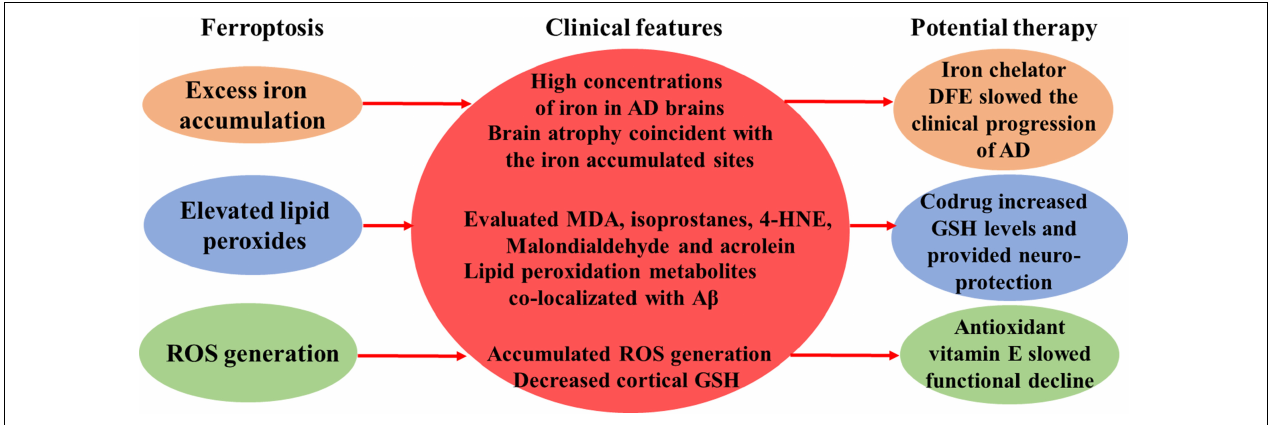
FIGURE 1 | Clinical features of ferroptosis in